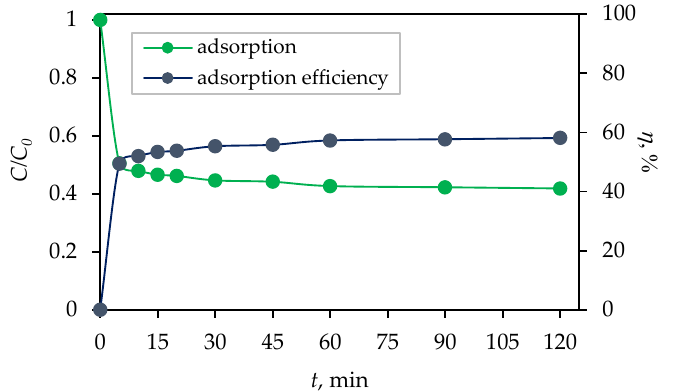
Figure 5. Dark adsorption and adsorption efficiency ( η ; %) of ciprofloxacin (CIP) by Fe 3 O 4 /SiO 2 /TiO 2 nanocomposites synthesized at 100 °C as a function of time ( c (CIP) = 10 mg dm −3 , V (CIP) = 100 cm 3 , m (core – shell photocatalyst) = 50 mg, and T = 25 °C).